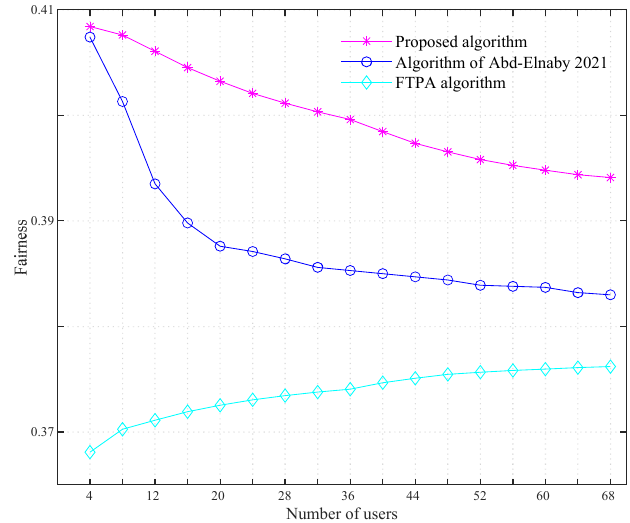
Figure 4. Fairness varies with the number of users.